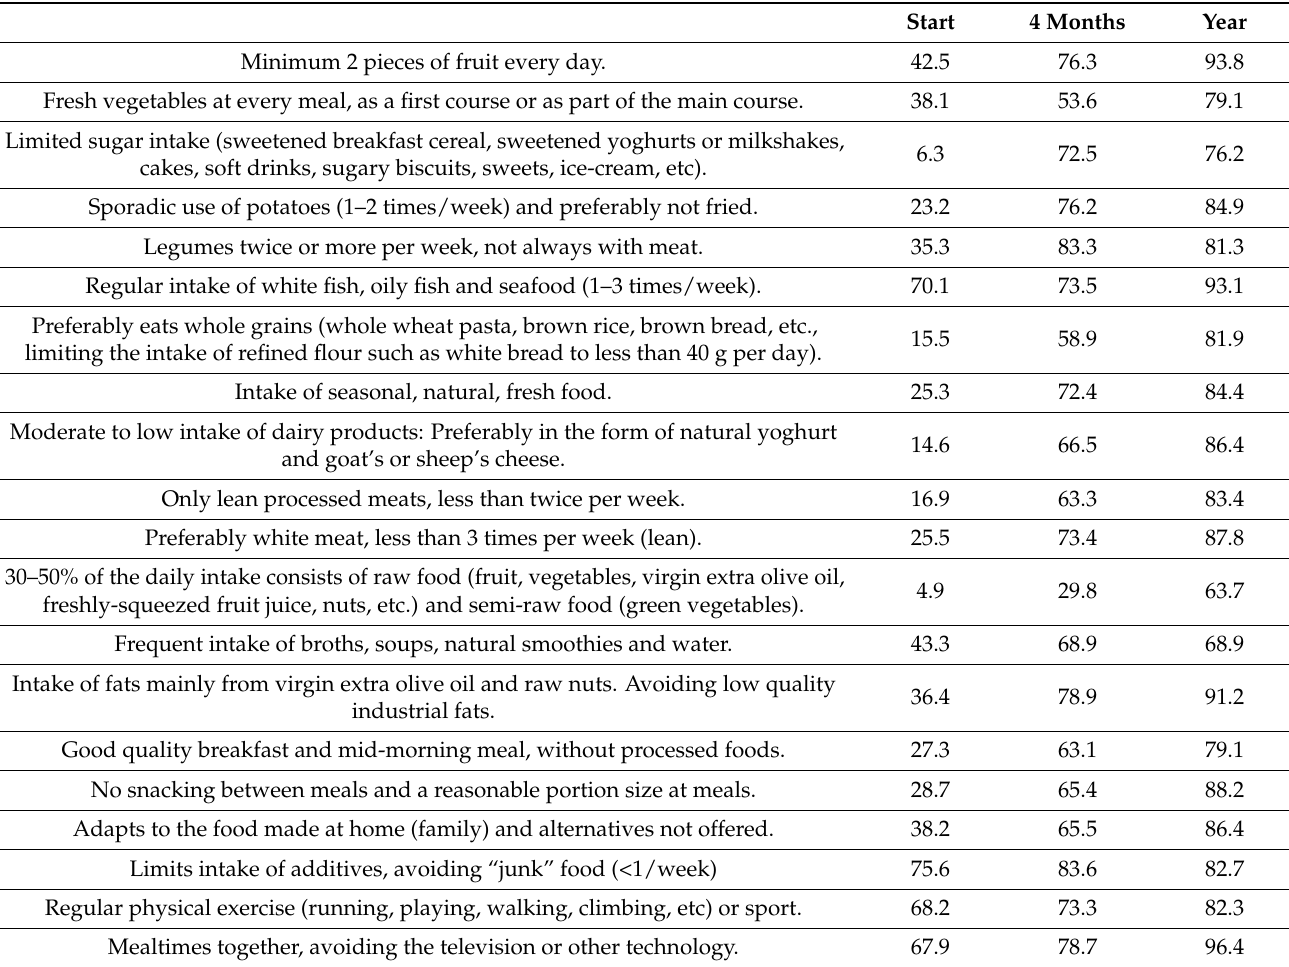
Table 8. TMD Test